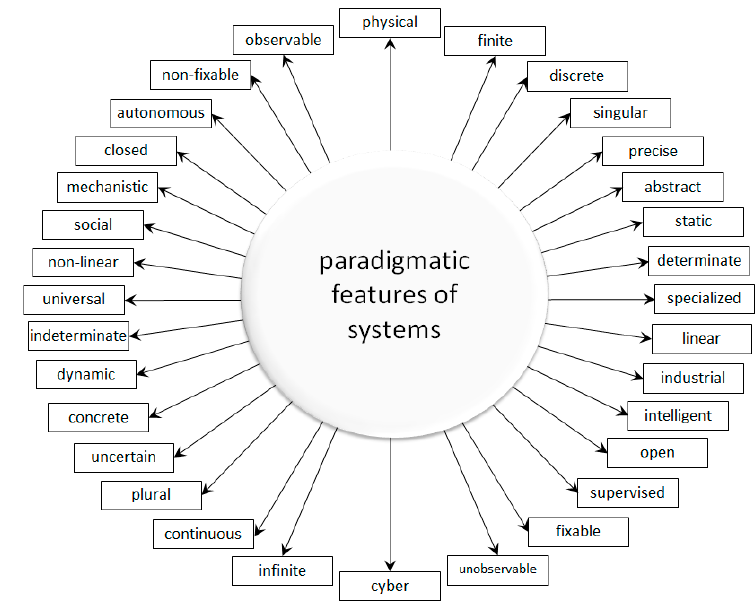
Figure 1. Distinguishing paradigmatic features of engineered systems.